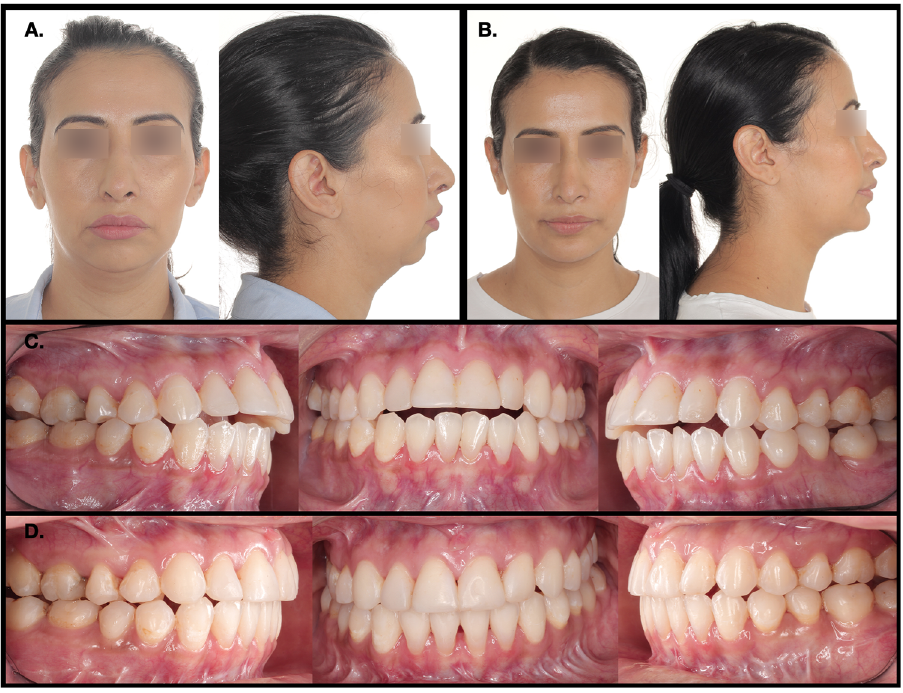
Fig. 6. Patient two: A, C. Presurgical (Front and right pro fi le view) and occlusion (Left, Front and right view), B, D. Postsurgical (Front and right pro fi le view) and occlusion (Left, Front and right view) 1 year postsurgical. *Osteotomy Lefort I, BSSOM, osteotomy chin, and meniscopexy TMJ.